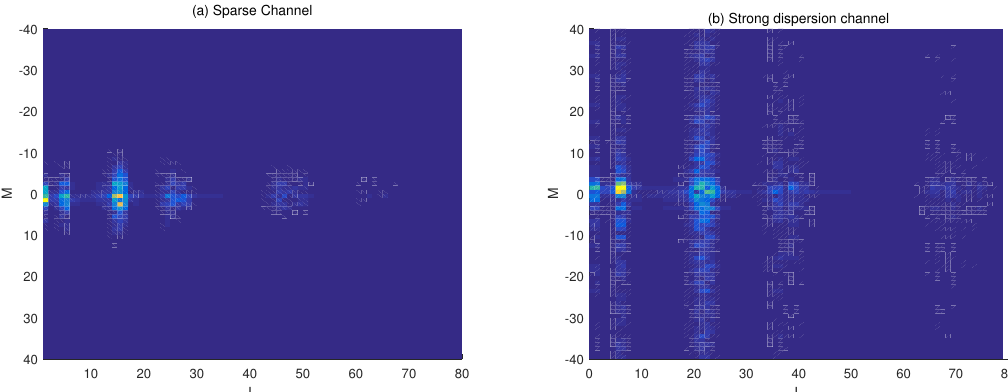
Figure 1. Channel DDSM generated by the model in [1]. ( a ) Sparse Case; ( b ) Dispersion